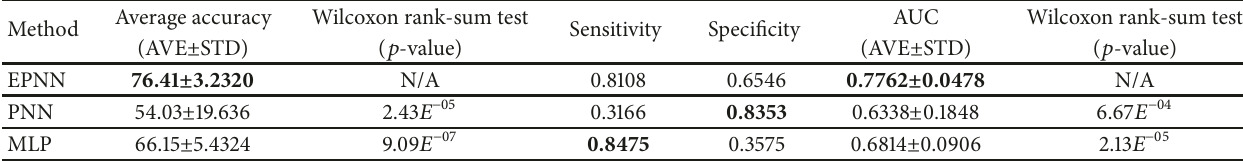
Table 13: Experimental results for Distress data